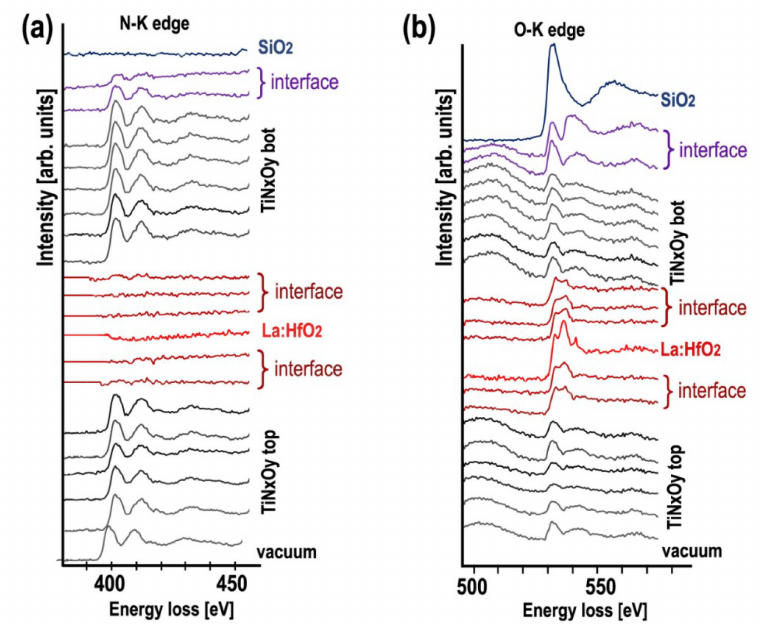
Figure 6. Evolution of ELNES through the SiO 2 —TiN x O y bot—La:HfO 2 —TiN x O y top interfaces: